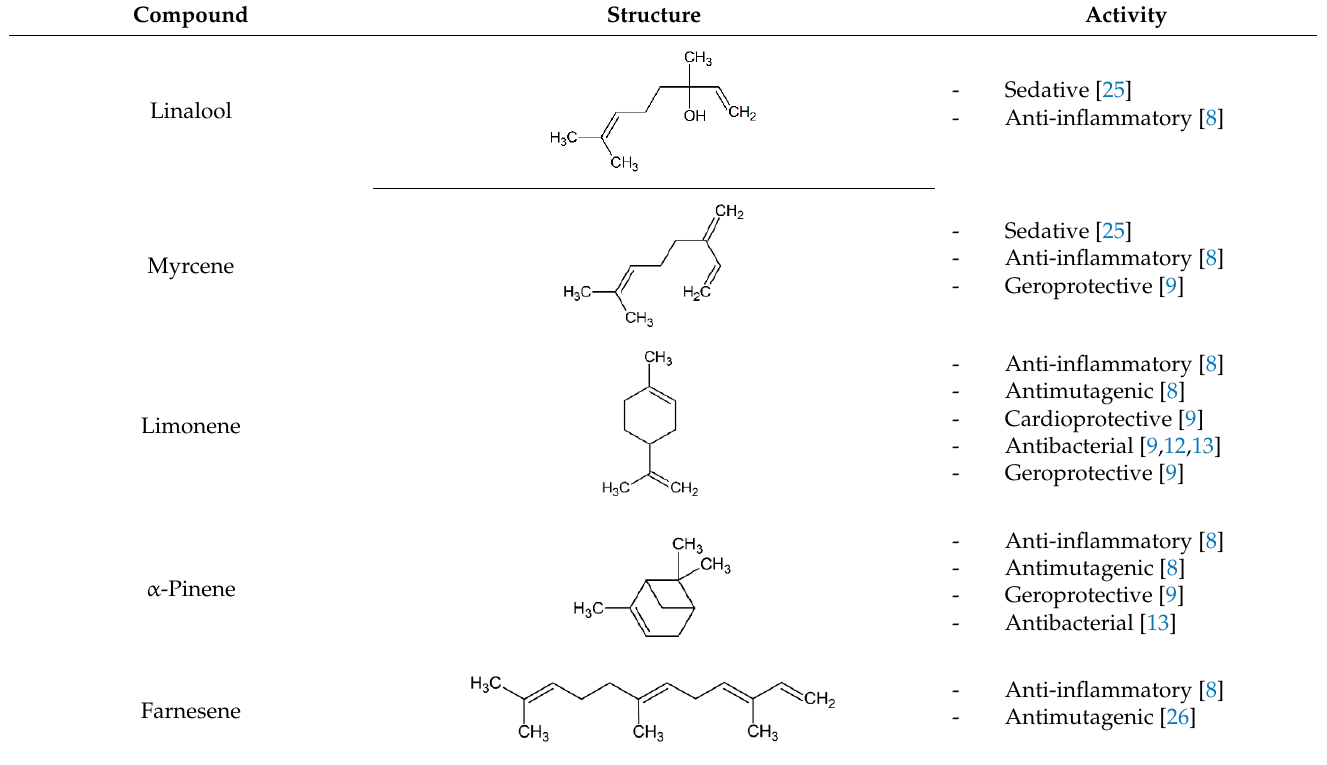
Table 1. Chemical structure and main effects of the tested compounds.